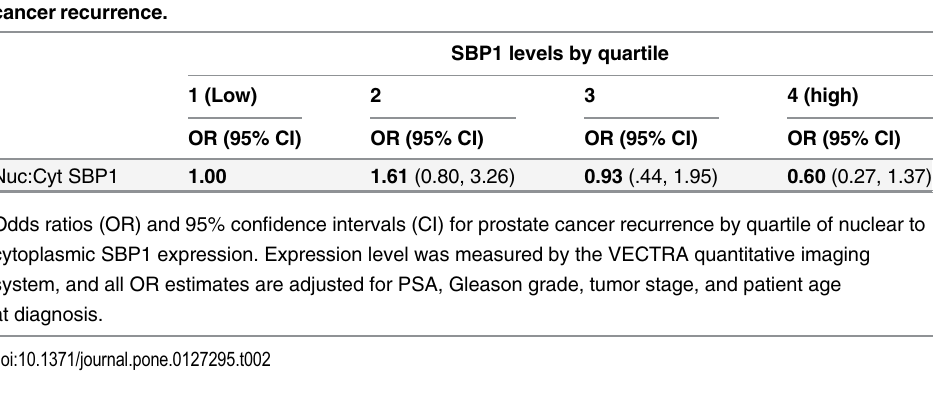
Table 2. There was no association between the nuclear to cytoplasmic ratio of SBP1 and prostate cancer recurrence.